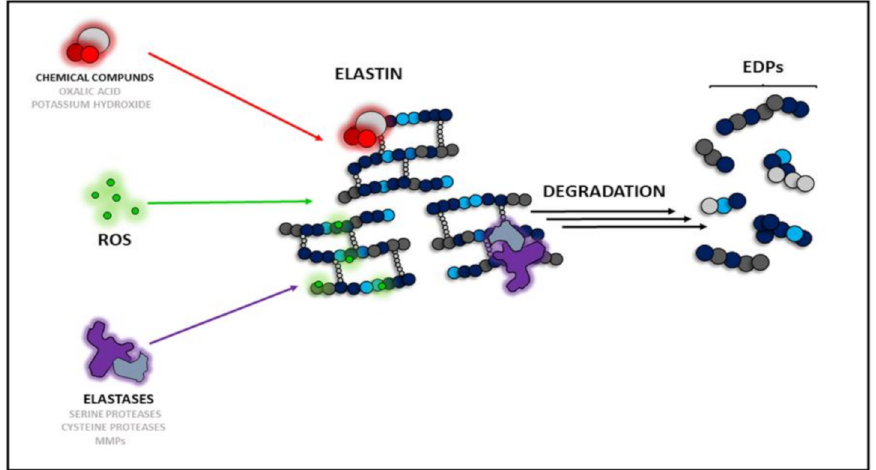
Figure 1. Types of elastin degradation factors: chemicals, ROS-dependent, and enzyme-dependent. ROS—reactive oxygen species, MMPs—matrix metalloproteinases, EDPs—elastin derived